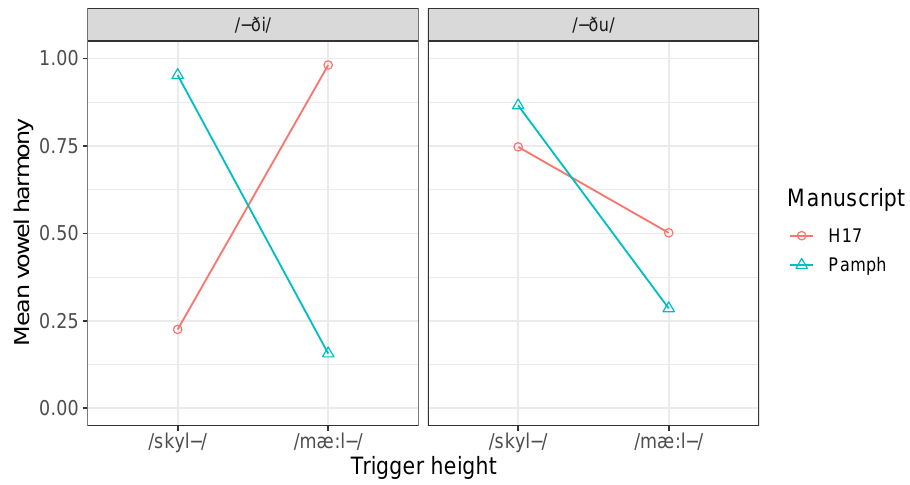
Figure 11: Highly asymmetric harmony levels following non-/high har- mony triggers as a result of lexicalisation in post-decay manuscripts In summary, Old Norwegian vowel harmony decay is characterised by a wide variety of lexicalising patterns. The current corpus illustrates that levelling historically harmonising suf(cid:976)ixes sets in early in harmony decay, attested to some degree in all pre-, intermediary, and post-decay stages of this sound change. The progressive diffusion of suf(cid:976)ixes to non- alternating classes leaves progressively fewer morphemes subject to har- mony. This reduces the overall rate of harmonisation and increases the dispersion between vowel classes’ height correspondence, which is visu- alised very clearly by the kind of trumpet shape of dispersing harmony patterns in Figure 6. These effects of decreasing harmony frequency and increasing variance in vowels’ harmony behaviours motivate further har- mony